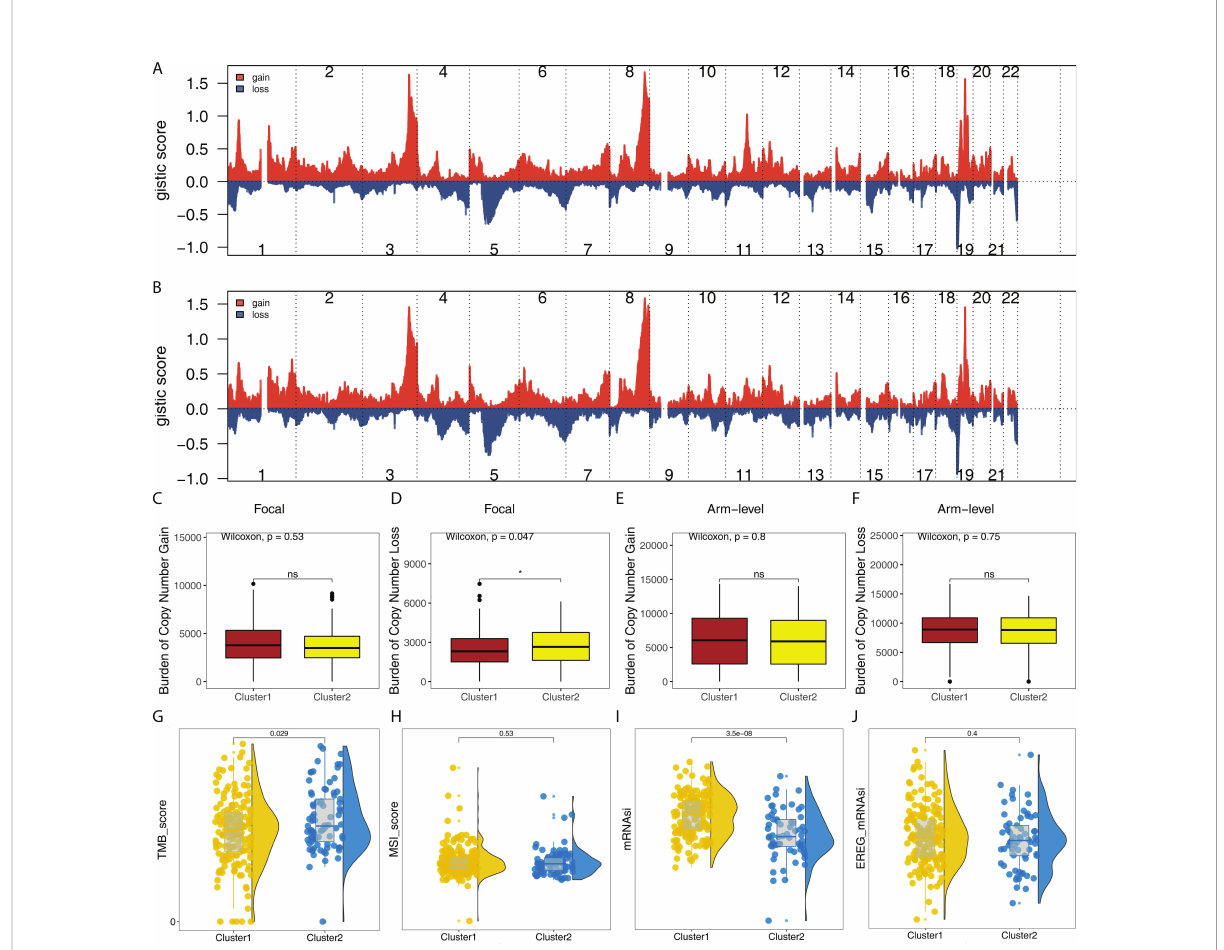
FIGURE 6 Genomic instability analysis. (A) The gistic score of copy number pro fi les of TCGA-OV in Cluster1; (B) The gistic score of copy number pro fi les of TCGA-OV in Cluster2; (C – F) The difference of CNV burden in focal gain, focal loss, arm-level gain and arm-level loss in Cluster1 and Cluster2 patients; (G – J) The difference of TMB, MSI, mRNAsi and EREG-mRNAsi in Cluster1 and Cluster2 patients. * = P < 0.05. The expanded form of ns = not signi fi